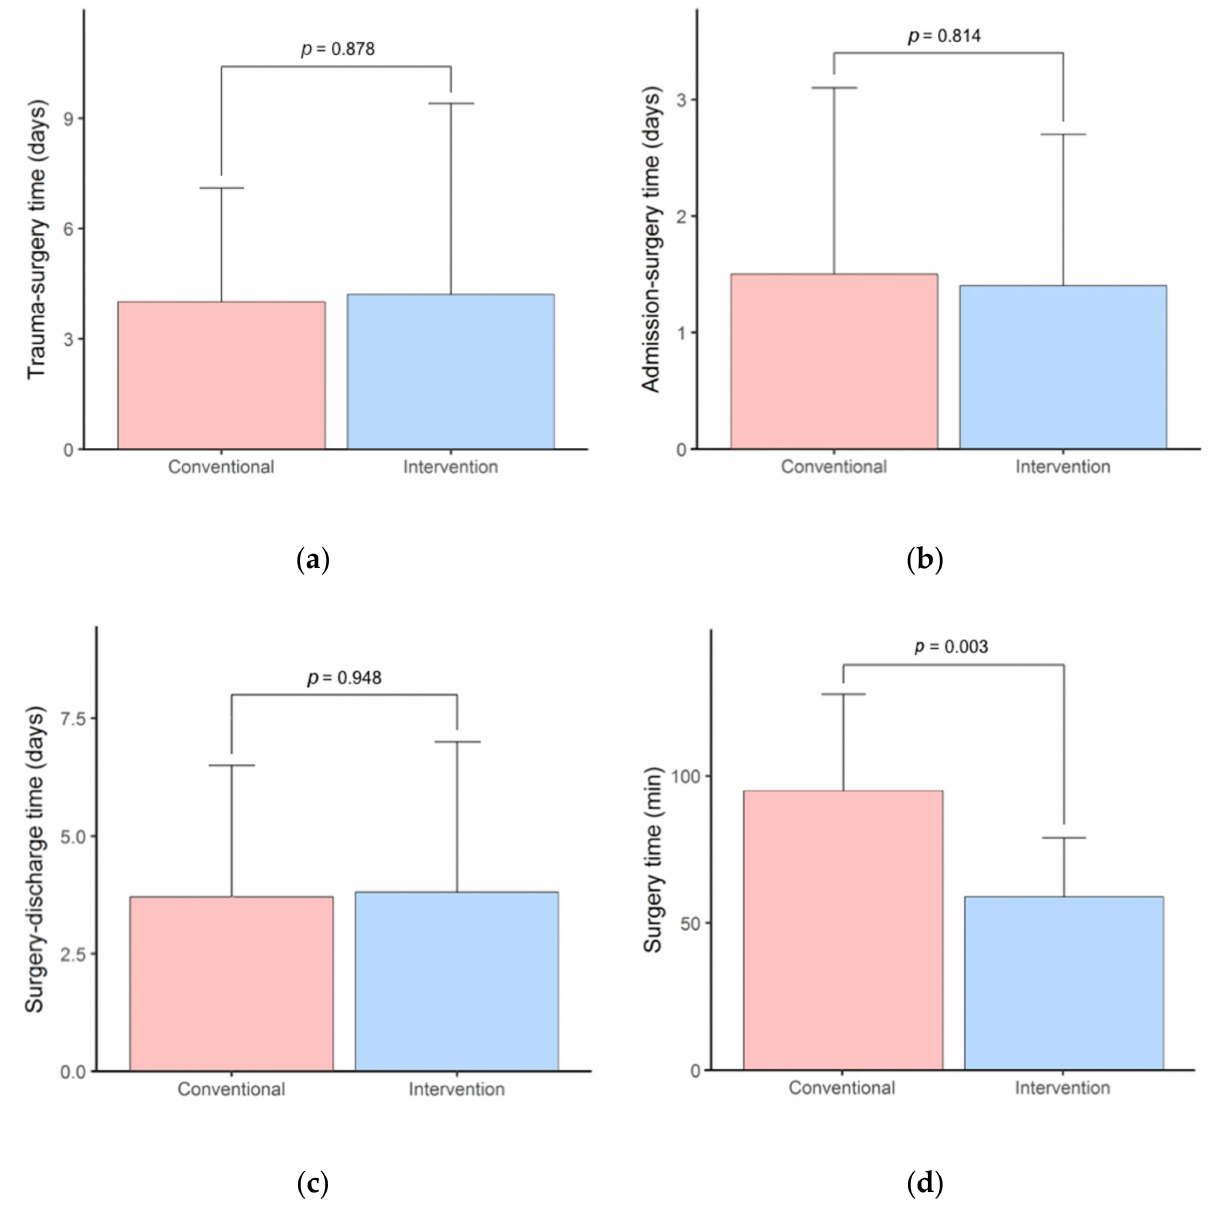
Figure 3. Comparison of different times between the conventional and intervention group: ( a ) time from trauma to surgery (days); ( b ) time from admission to surgery (days); ( c ) time from surgery to discharge (days); ( d ) duration of surgery (minutes) from incision to